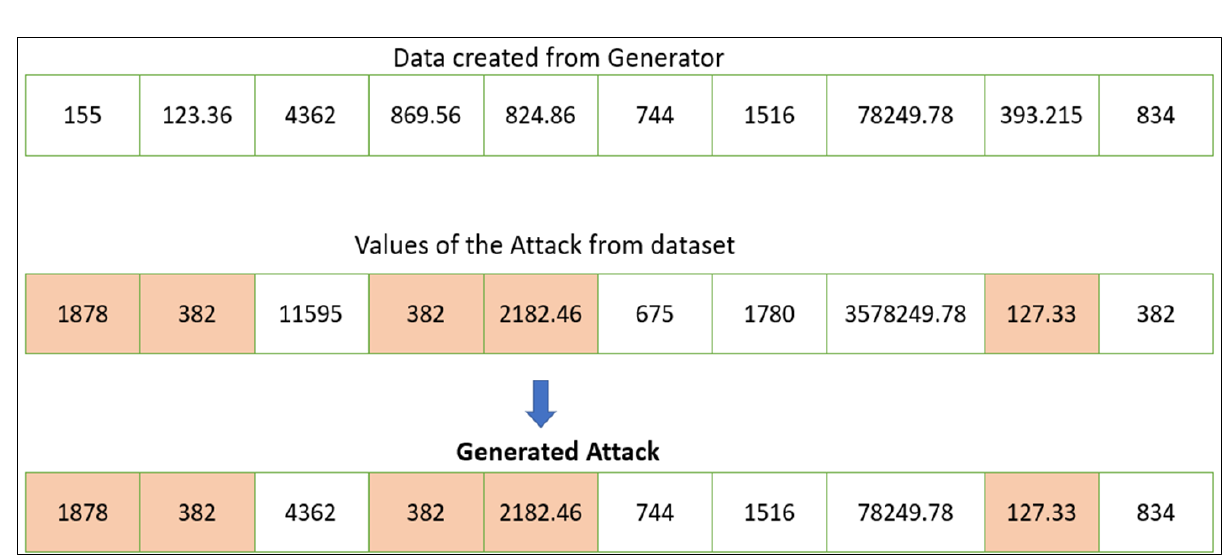
Figure 3. Generating the adversarial DDoS/DoS attack.